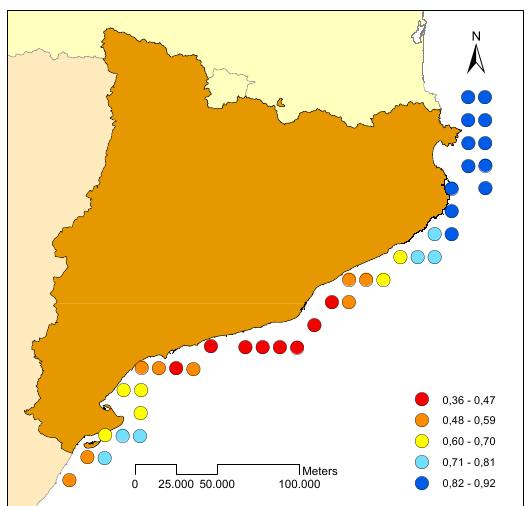
Fig. 6. Circular correlation between wind and wave direction in stormy